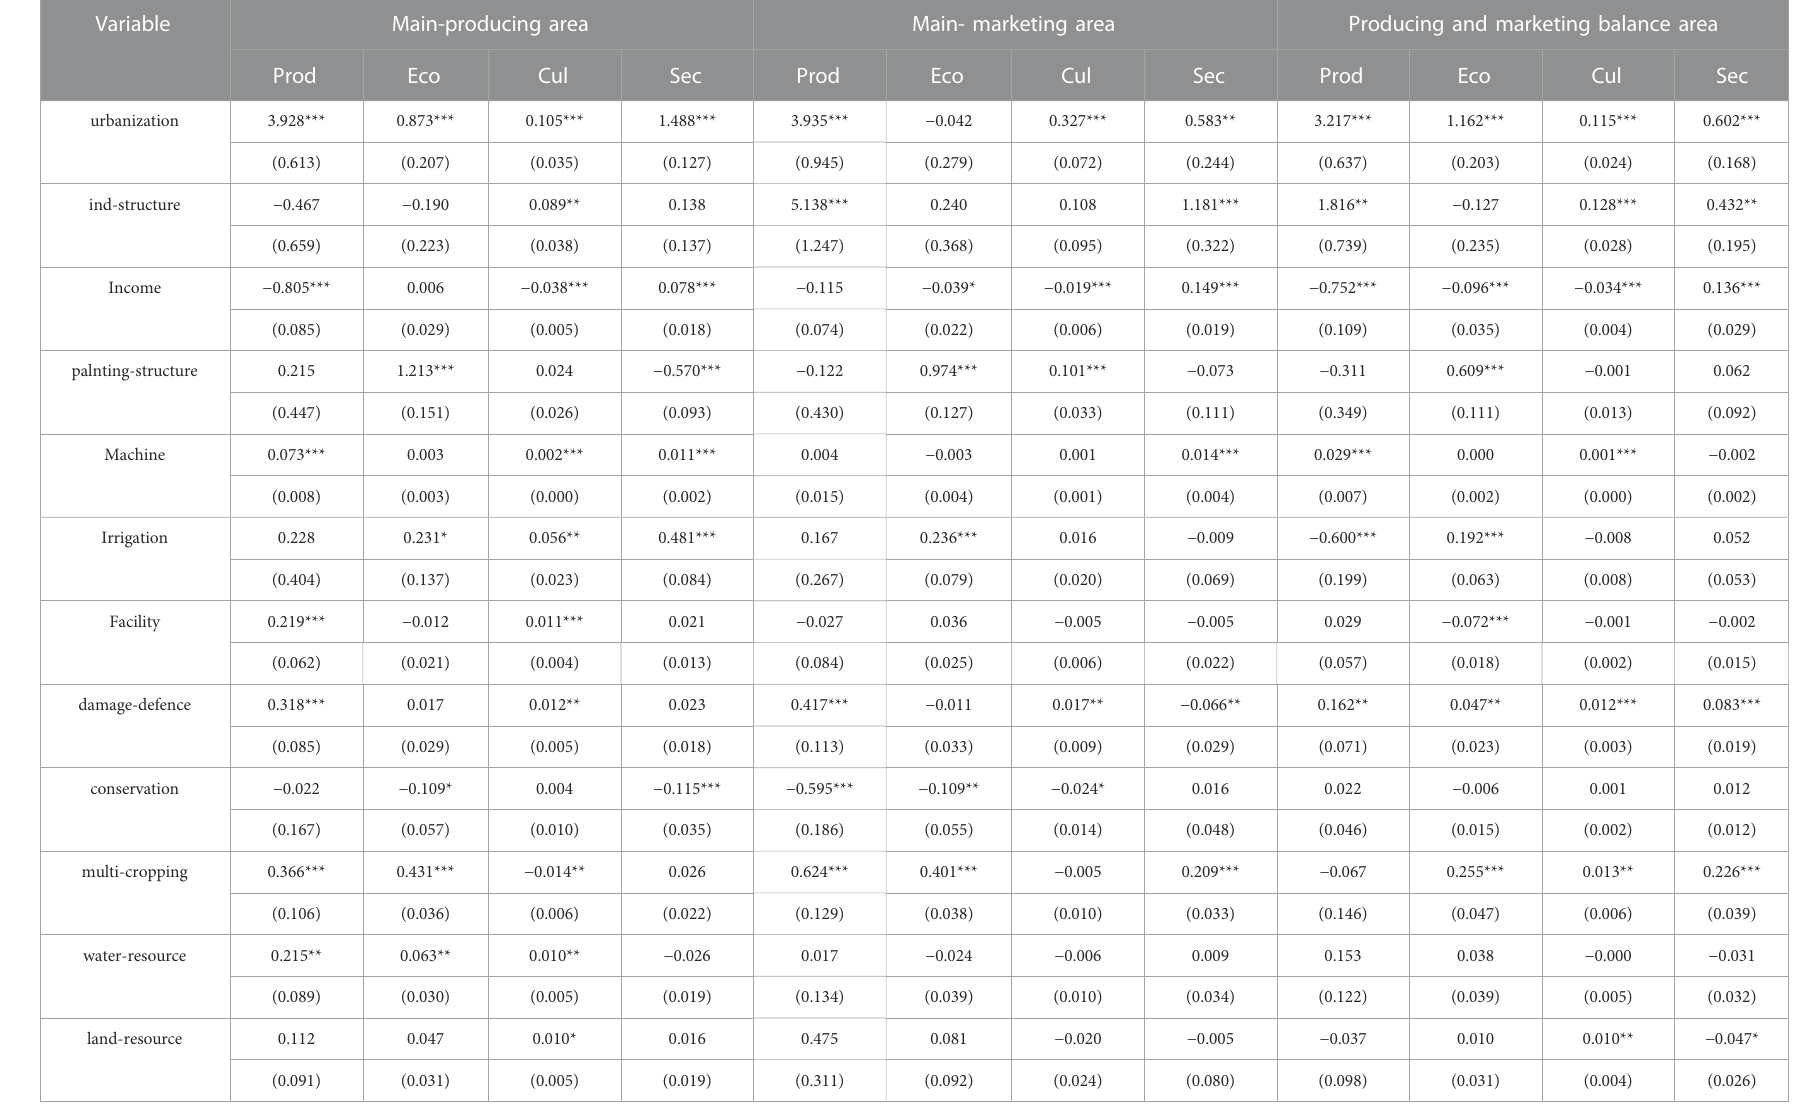
TABLE 4 Heterogeneity test